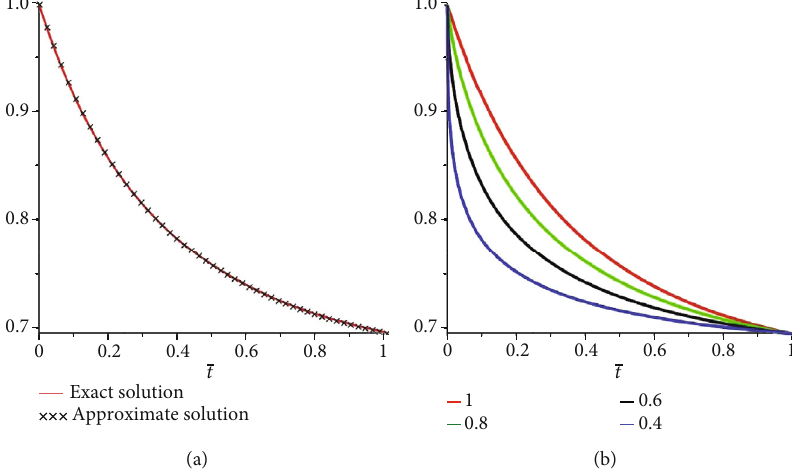
Figure 2: (a) The fi rst fi gure shows the actual and analytical solution, and (b) the second graph is various fractional order of β of Case